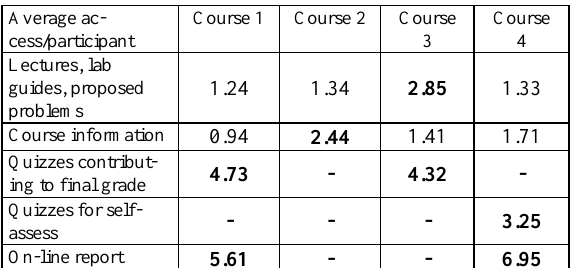
TABLE VIII. C ASE S TUDIES S UMMARY R